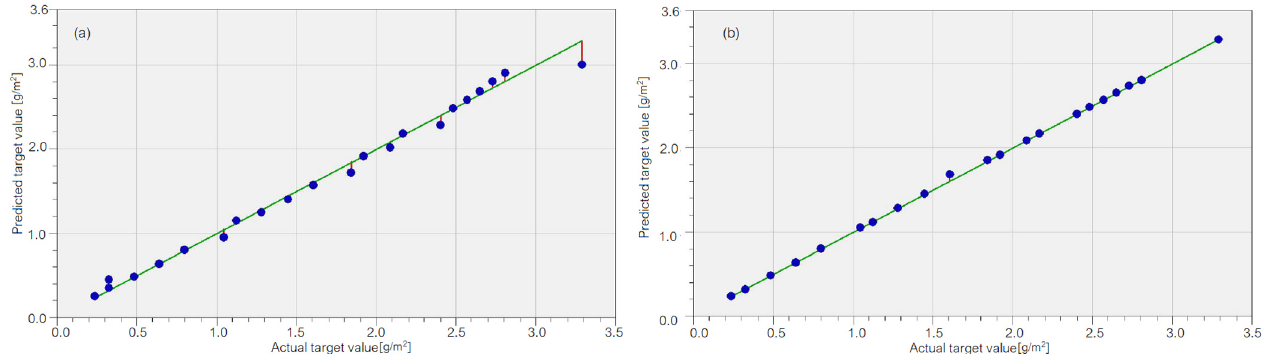
Figure 7. The computed values (called “predicted target values”) vs. the recorded ones (called “actual target values”) in ( a ) the SVR model and ( b ) the GRNN model for the brass sample. Overall, the best model is GRNN because there are no significant mismatches between the parameters’ values on the Test set for both methods, but on the Training set, MAPE is much lower for GRNN than for SVR; overall, the best model is GRNN.